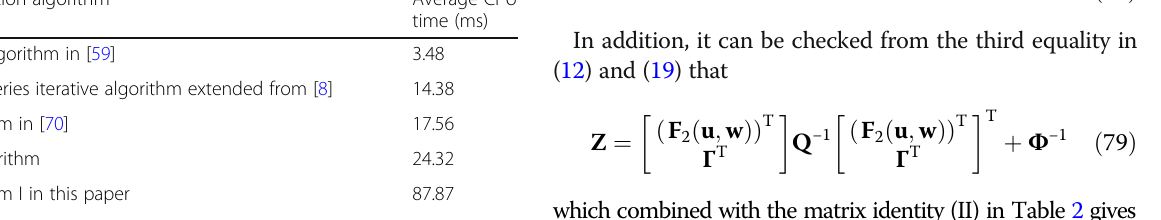
Table 5 Comparison of the running time Localization